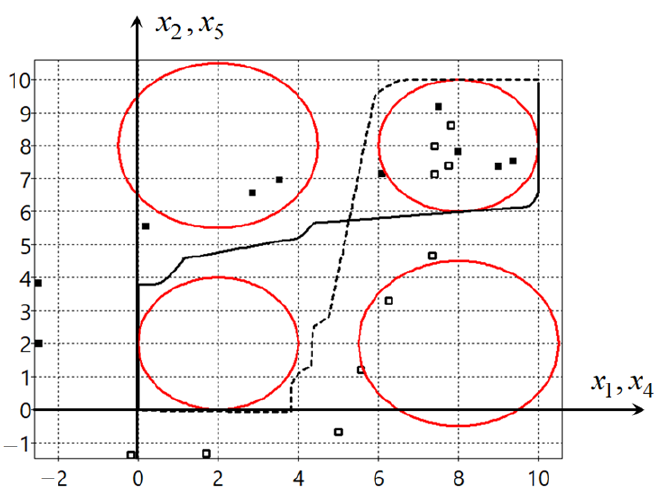
Figure 5. Optimal trajectories on the horizontal